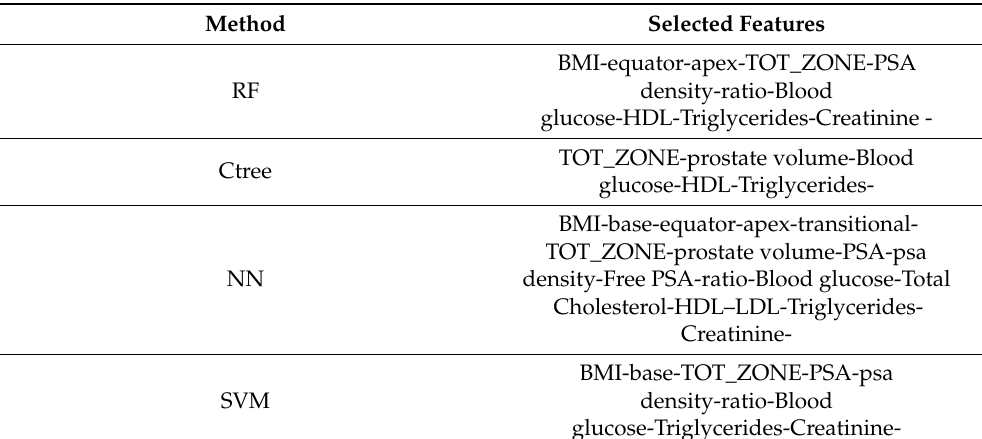
Table 3. For each machine learning algorithm, the selected features are reported.